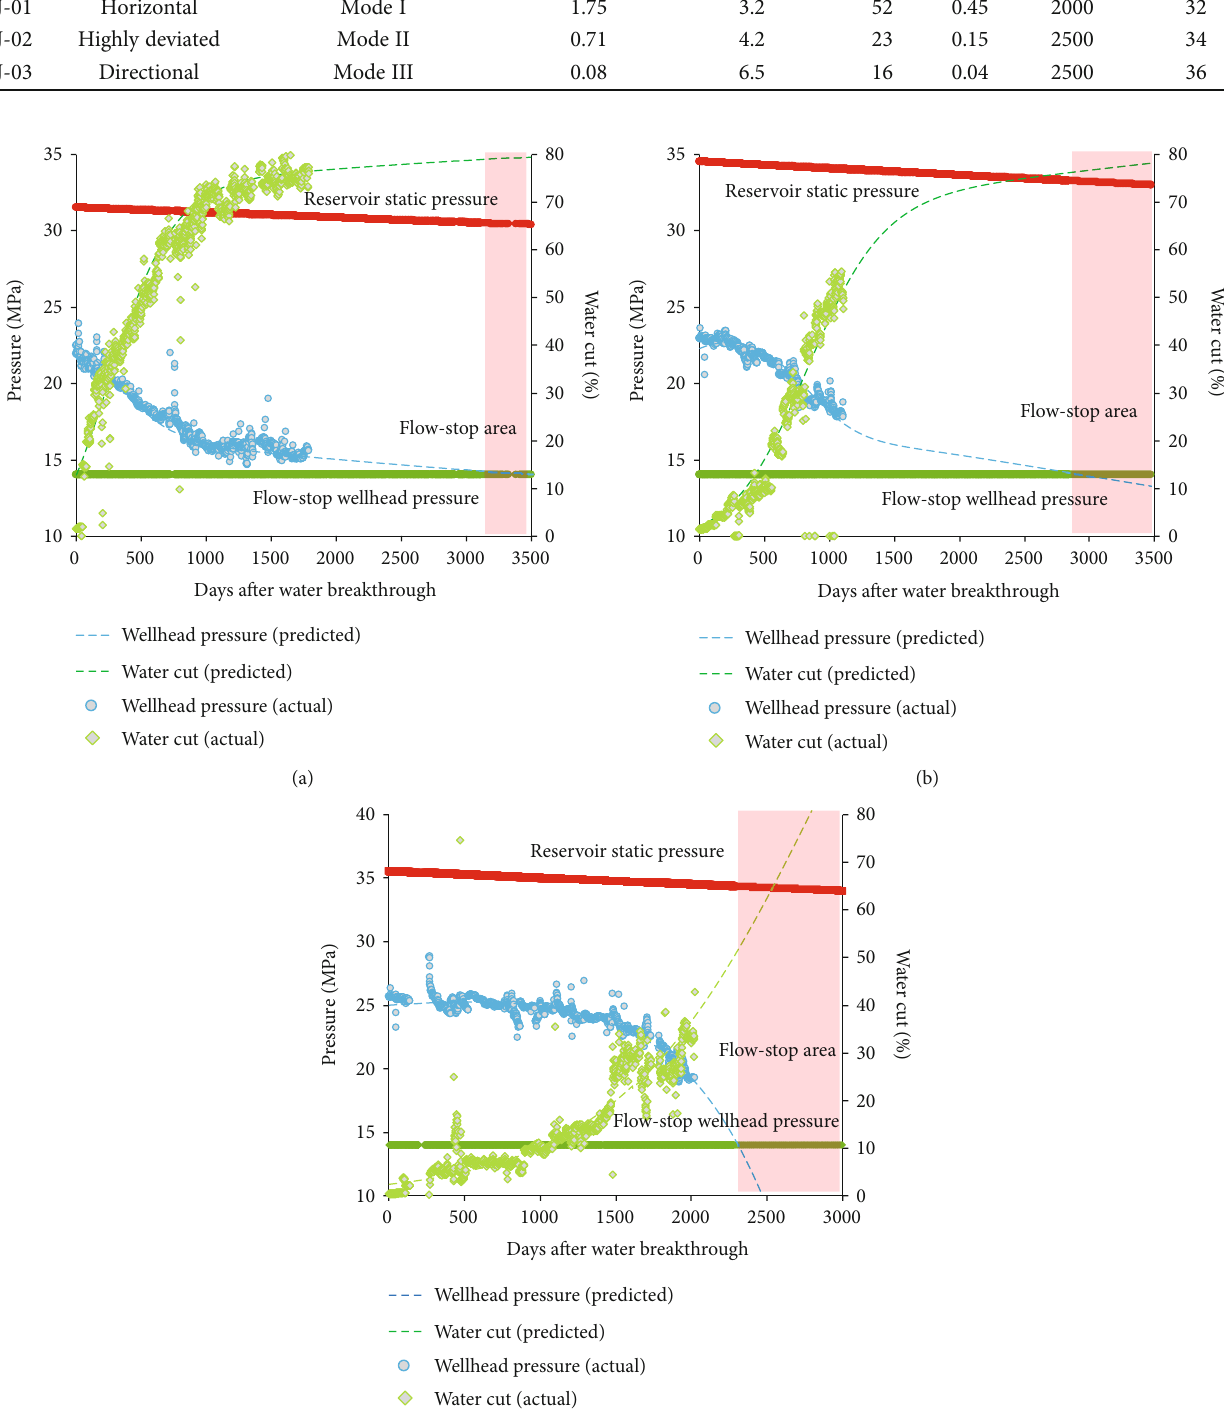
Figure 8: The prediction results of water-cut and wellhead pressure. (a) The prediction result of J-01. (b) The prediction result of J-02. (c) The prediction result of